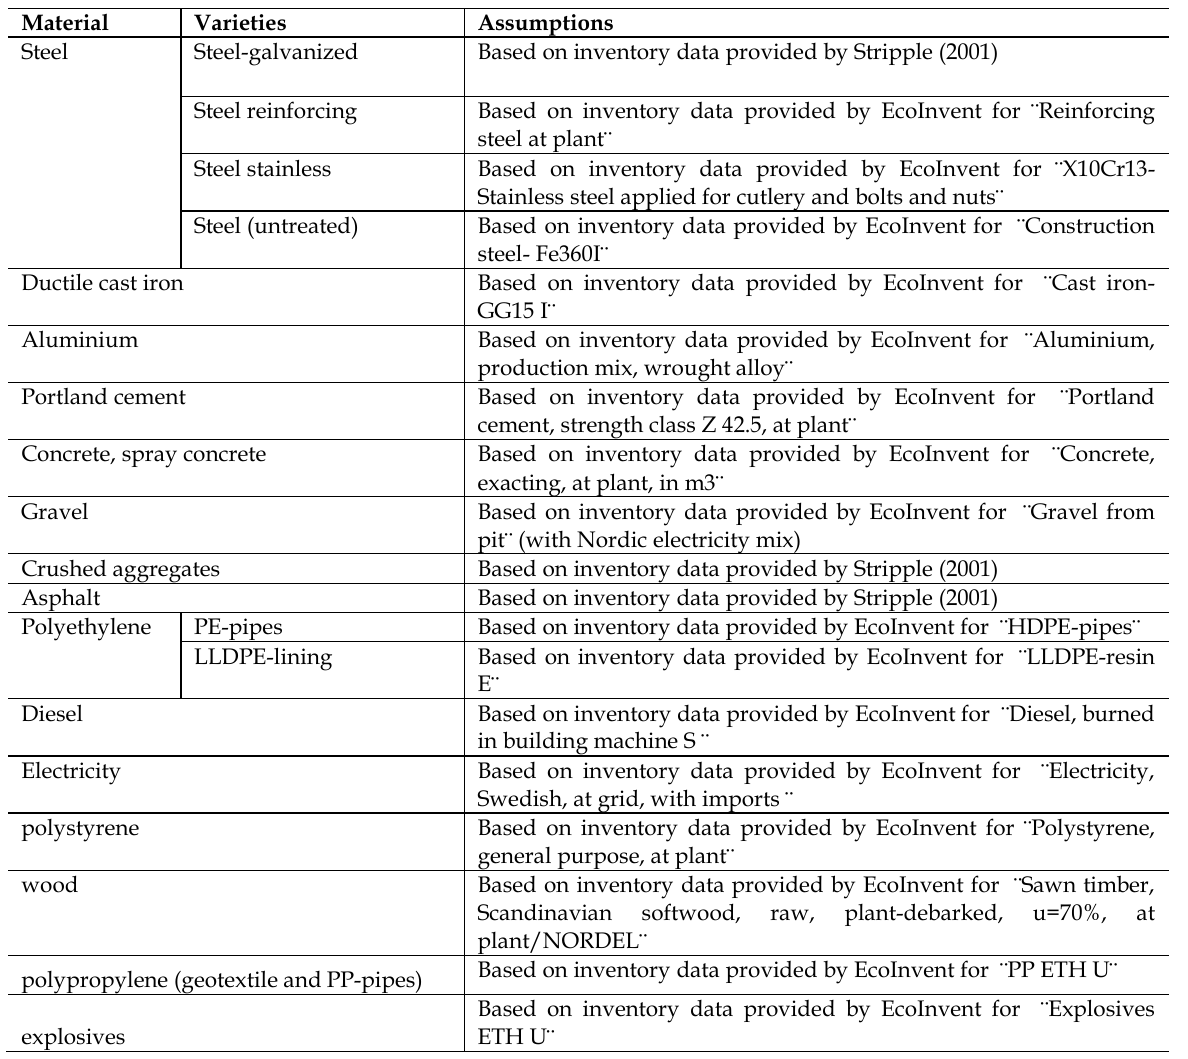
Table B-2 Assumptions for each group of materials in SimaPro